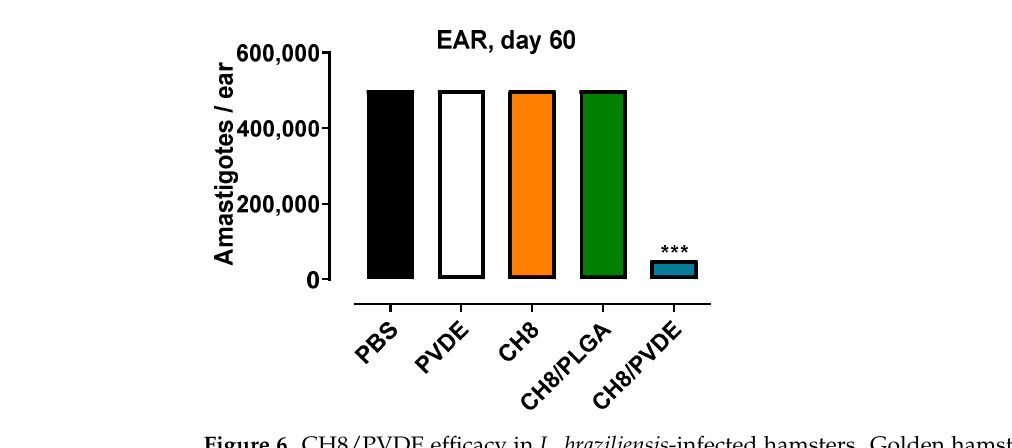
10 6 L. amazonensis - GFP promastigotes in the ear pinnae and treated 7 days later with a single in-